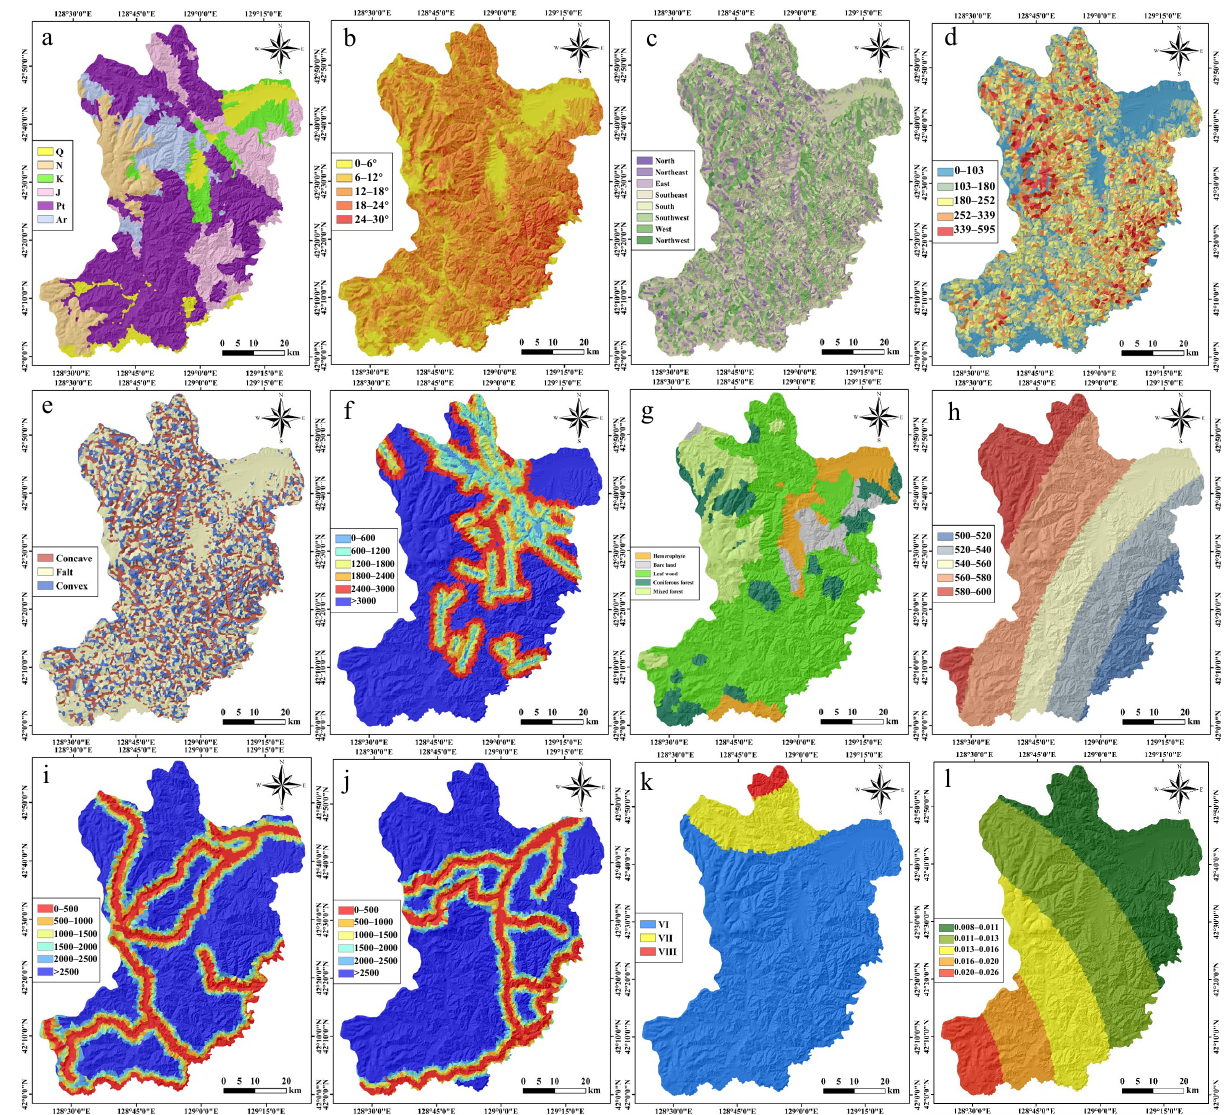
Figure 4. The conditioning factors for landslide susceptibility mapping: ( a ) geology, ( b ) slope angle, ( c ) slope aspect, ( d ) topographic relief, ( e ) curvature, ( f ) distance to fault, ( g ) land use, ( h ) average annual rainfall, ( i ) distance to river, ( j ) distance to road, ( k ) basic earthquake intensity, and ( l ) volcanic earthquake.